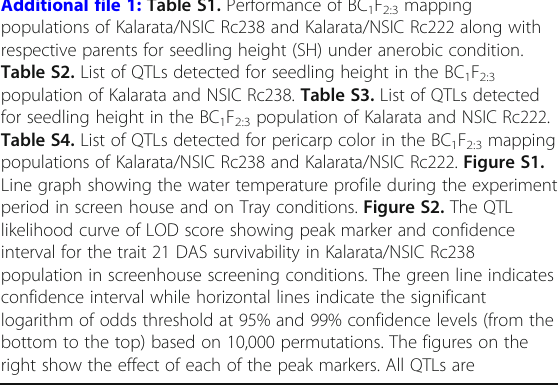
Table S4. List of QTLs detected for pericarp color in the BC 1 F 2:3 mapping populations of Kalarata/NSIC Rc238 and Kalarata/NSIC Rc222. Figure S1. Line graph showing the water temperature profile during the experiment period in screen house and on Tray conditions. Figure S2. The QTL likelihood curve of LOD score showing peak marker and confidence interval for the trait 21 DAS survivability in Kalarata/NSIC Rc238 population in screenhouse screening conditions. The green line indicates confidence interval while horizontal lines indicate the significant logarithm of odds threshold at 95% and 99% confidence levels (from the bottom to the top) based on 10,000 permutations. The figures on the right show the effect of each of the peak markers. All QTLs